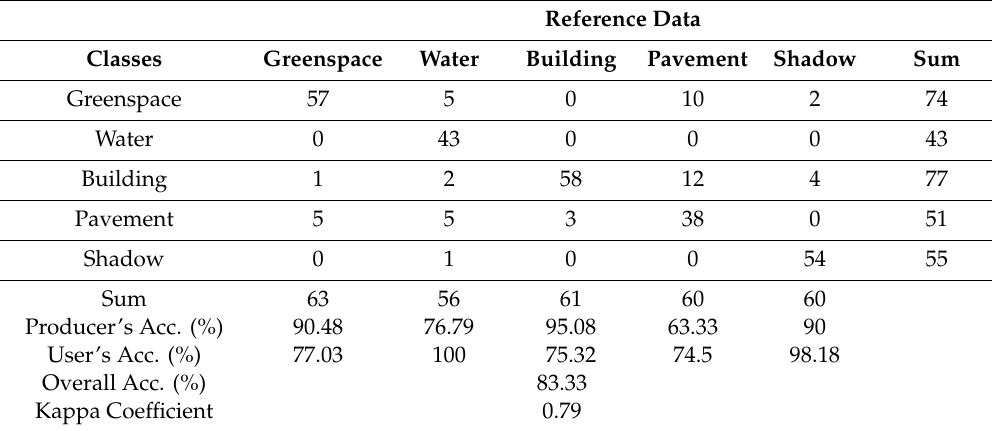
Table 4. The classification accuracies in Method 1.